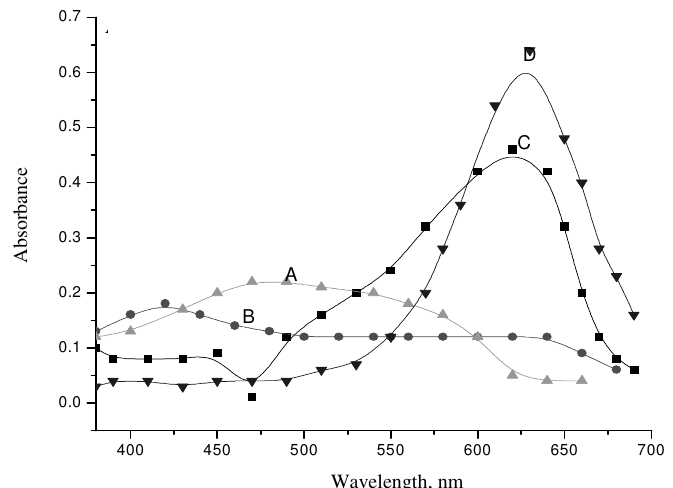
Figure 2. Absorption spectra of U(VI) at pH 5, A) CRAS-(Reagent); B) CRAS-CDMEAB- (Modified reagent); C) CRAS-U(VI)-(Binary complex) and D) CRAS-CDMEAB-U(VI)- (Ternary